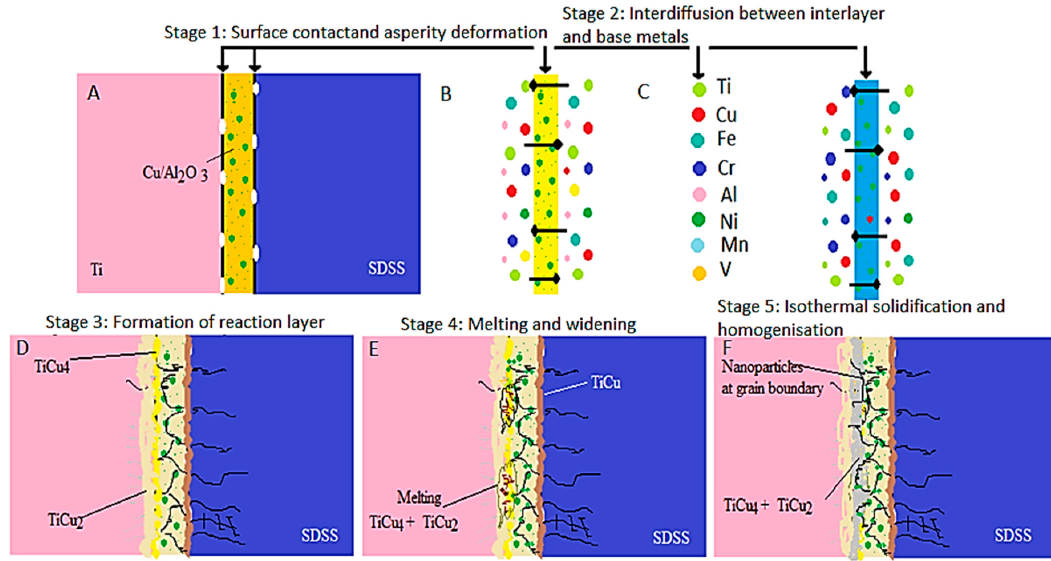
Figure 15. A schematic of the mechanism involved in bond formation of Ti–6Al–4V and super-duplex stainless steel using a Cu/Al 2 O 3 interlayer: ( A ) Initial surface contact and asperity deformation; ( B , C ) Interdiffusion between interlayers and base metals; ( D ) Formation of the reaction layers; ( E ) Eutectic ( B , C )Interdi ff usionbetweeninterlayersandbasemetals; ( D )Formationofthereactionlayers; ( E )Eutectic melting which occurs in samples bonded at 900 °C; ( F ) Isothermal solidification and homogenization melting which occurs in samples bonded at 900 ◦ C; ( F ) Isothermal solidification and homogenization of of the interface. the